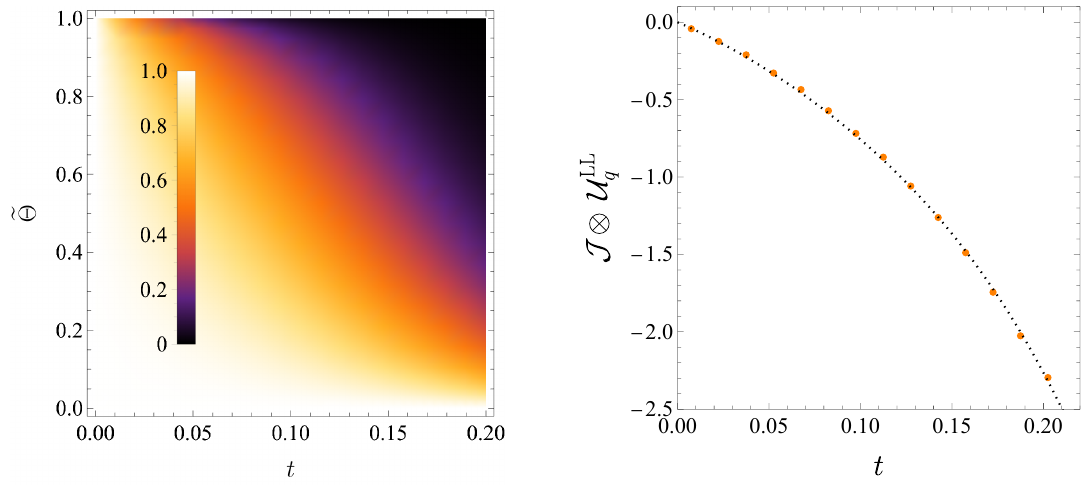
Figure 11 . The left plot shows the coft function U LL ( e Θ , t ) . The right plot shows the convolution q of the jet and coft function, more precisely the convolution with the plus distribution shown in (7.7). The orange dots correspond to the results of the parton shower; the dotted line is the fourth-order polynomial in t fitted to these